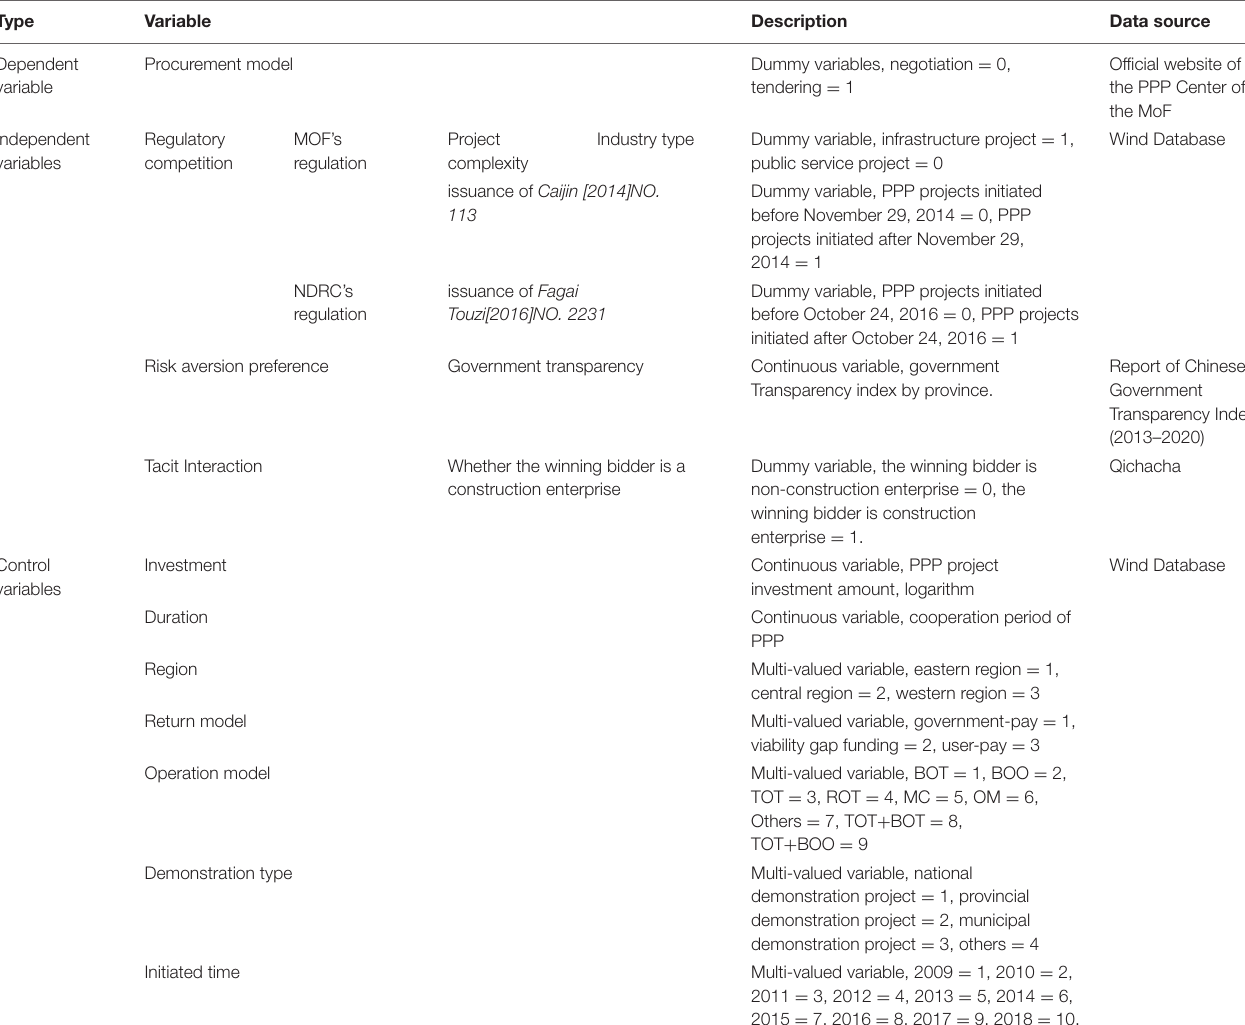
TABLE 2 | Description of